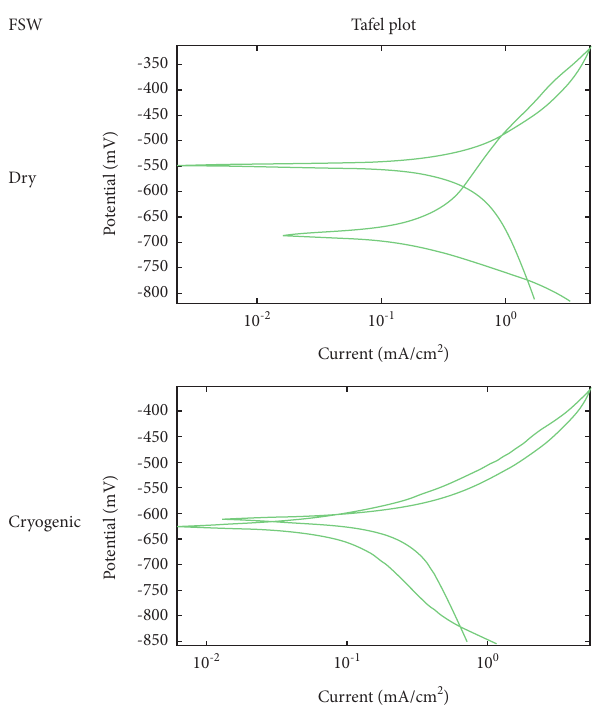
Figure 23: Corrosion analysis for dry and cryogenic friction stir welding of AA 7075 aluminium